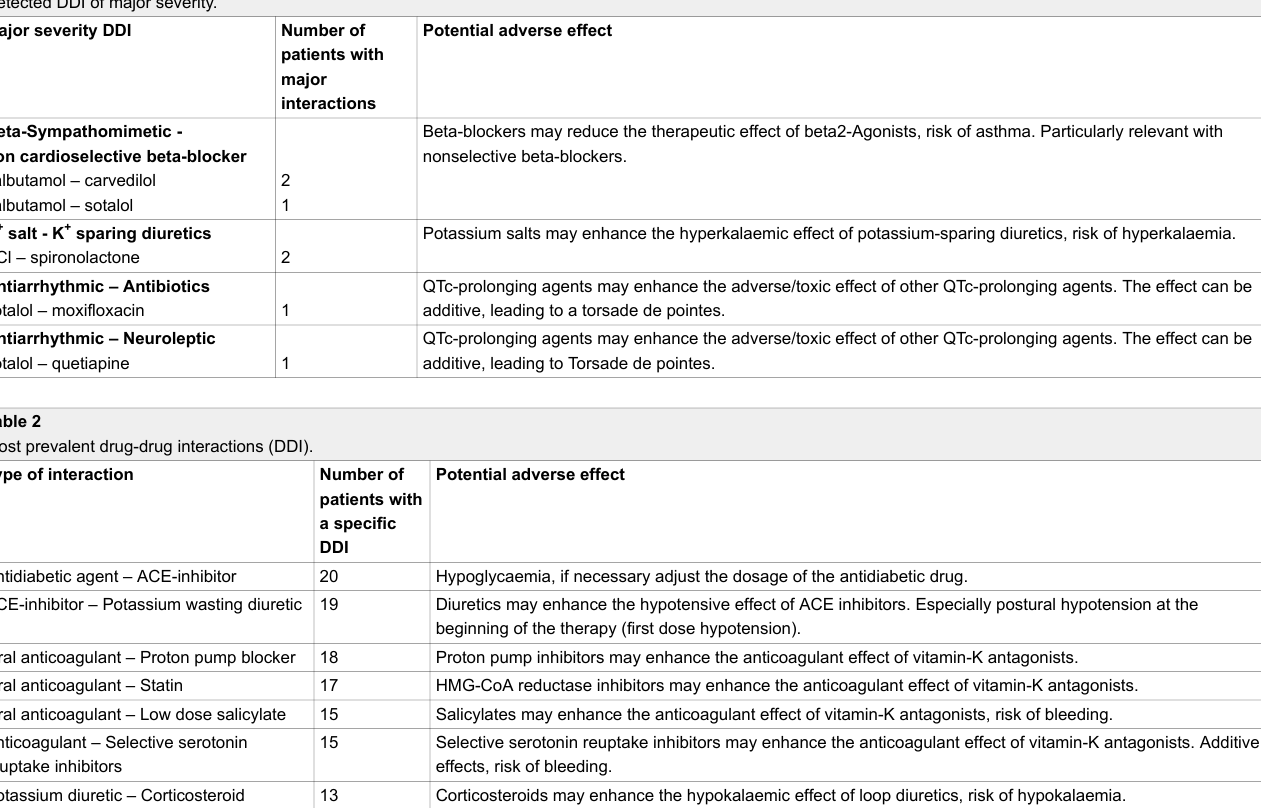
Table 1 Detected DDI of major severity.